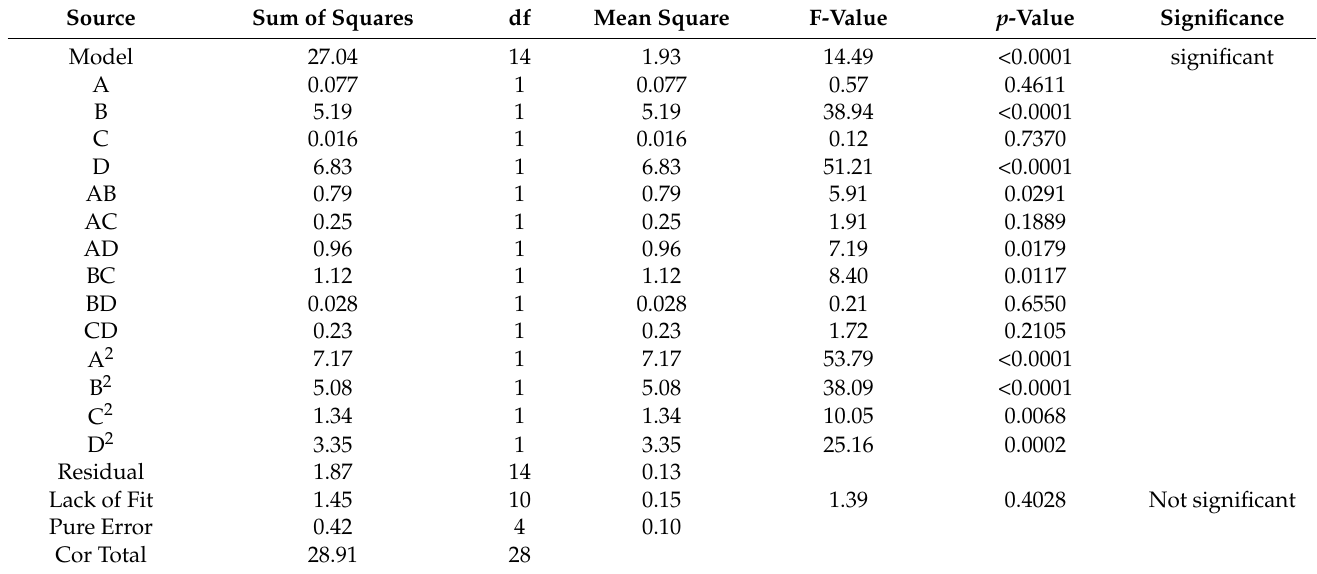
Table 4. Analysis of variance of the spore production response surface model of the strain